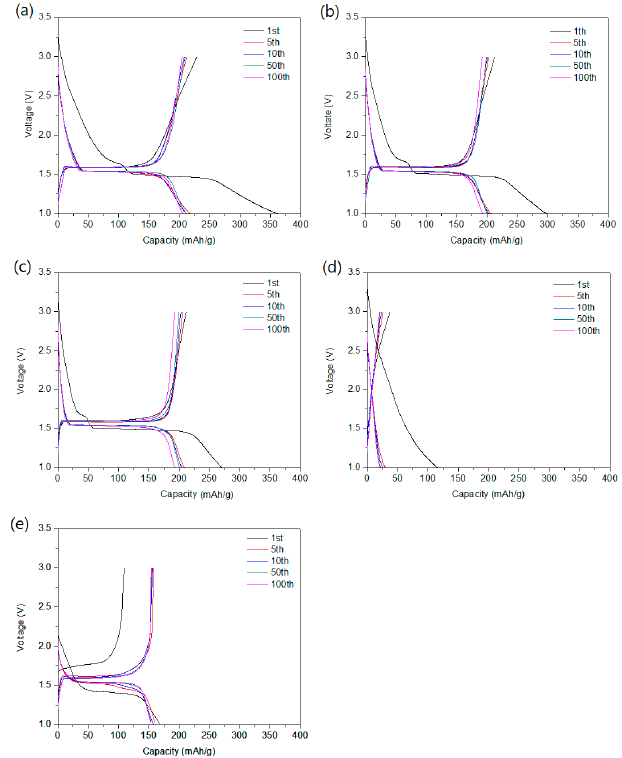
Figure 5. Discharge–charge curve of the ( a ) LC40 film, ( b ) LC50 film, ( c ) LC60 film, ( d ) buckypaper, and ( e ) LTO_Cu electrode at 1 C in the voltage window of 1–3 V (vs. Li + /Li).